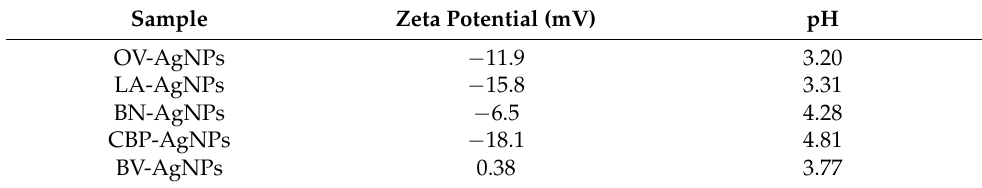
Table 6. Zeta potential and pH values of synthesised AgNPs from 5 mM AgNO 3